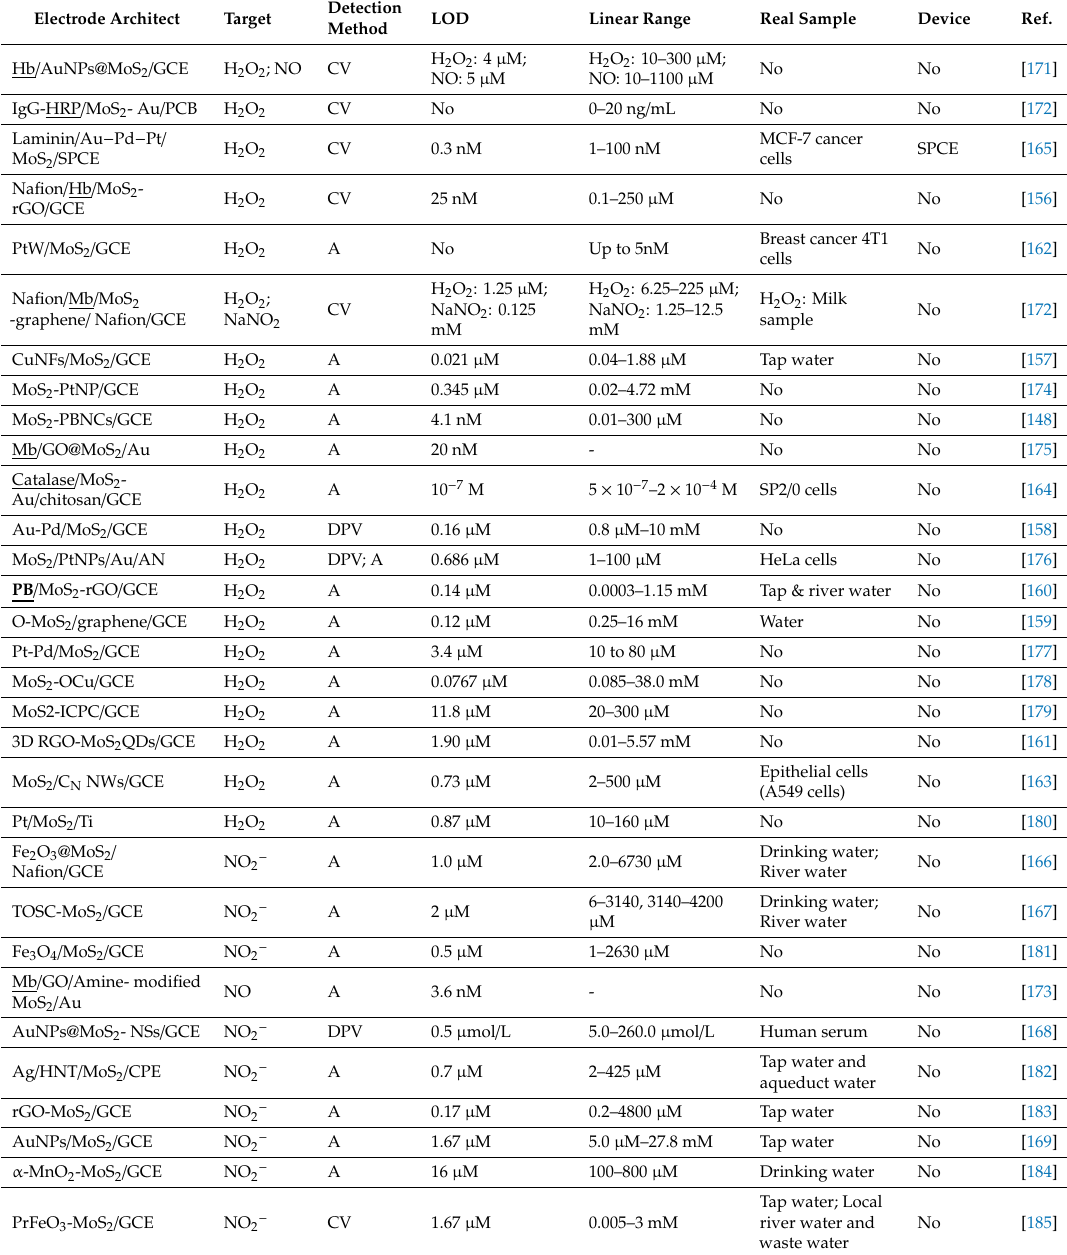
Table 6. Reported studies for MoS2-based electrochemical detection of H 2 O 2 and NO. The underlined terms are the